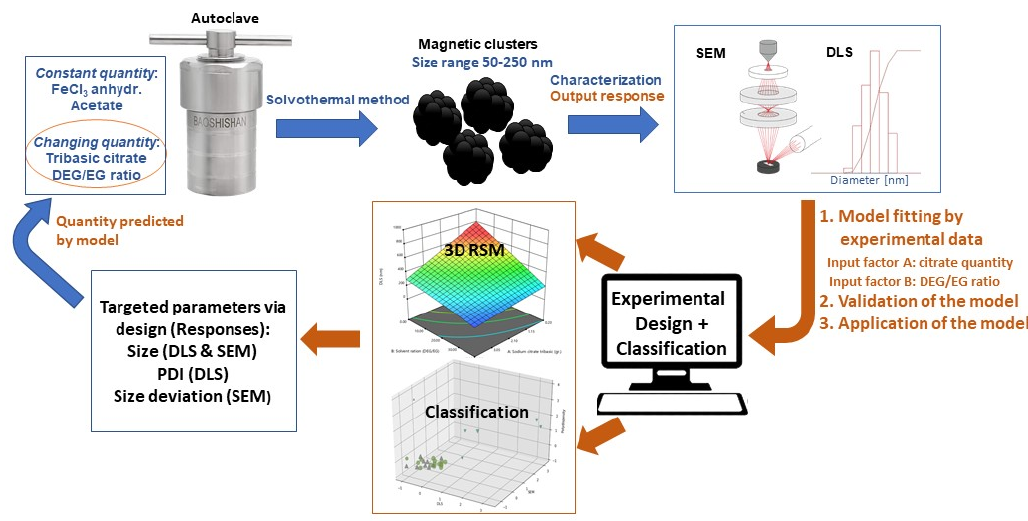
Figure 1. Schematic representation of the experimental and computational work to construct the model